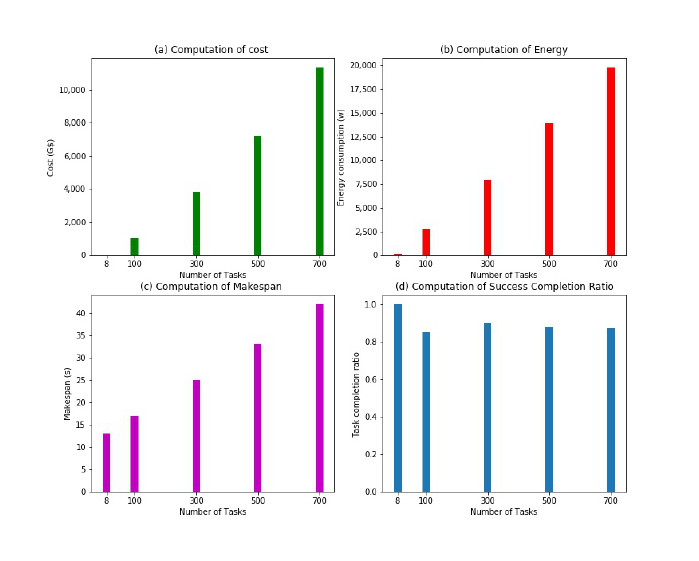
Figure 6. Cost, energy consumption, makespan, and task completion ratio in three fog